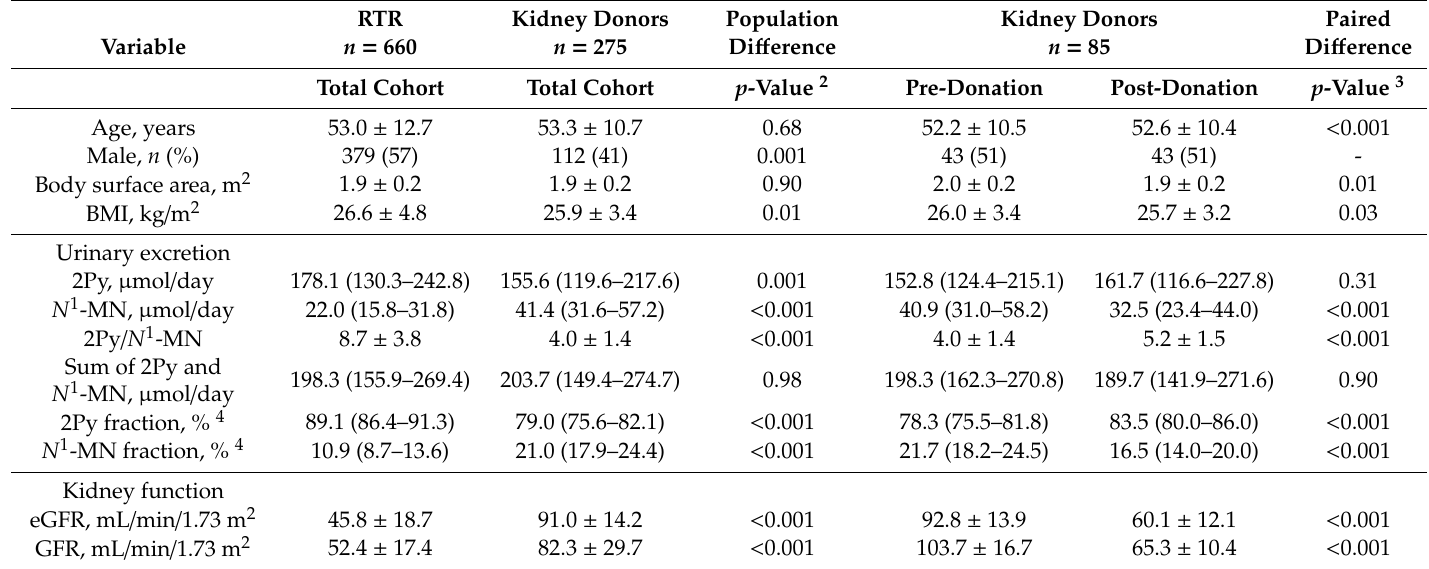
Table 1. Excretion of 2Py and N 1 -MN and kidney function in RTR and kidney donors before and after kidney donation 1